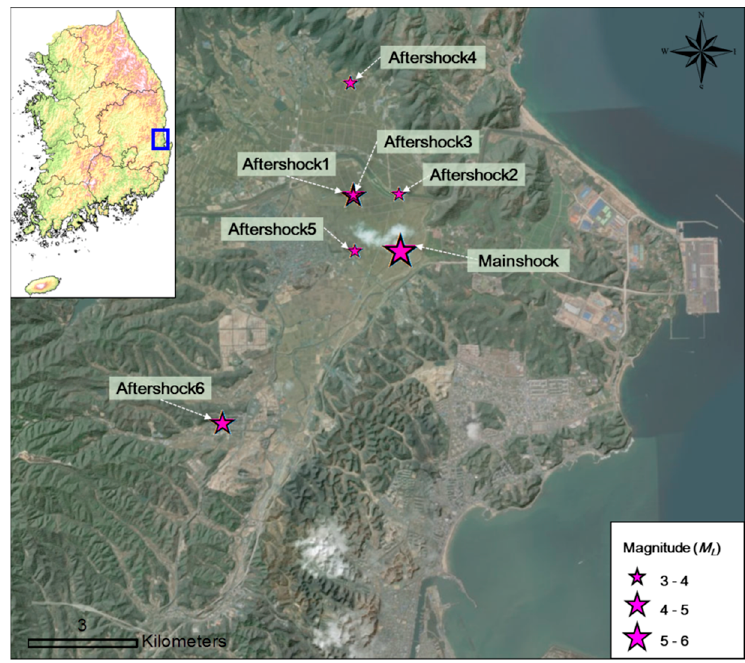
Figure 2. Epicenters of major events of the 2017 Pohang earthquake [1]. Figure 1. Epicenters of major events of the 2017 Pohang earthquake [1].